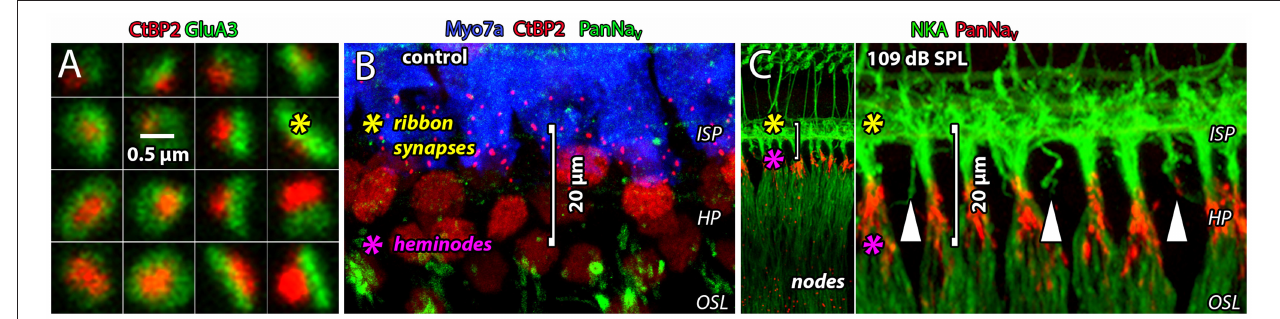
FIGURE 1 | Glutamatergic ribbon synapses and afferent fibers are vulnerable to noise exposure. (A) Square tiles ( ∼ 1 µ m 2 ) show 16 individual afferent ribbon synapses from the 2nd cochlear turn of a control cochlea. The presynaptic ribbon (red) is a cytoplasmic density anchored to the presynaptic membrane of the IHC. The main synaptic ribbon protein, Ribeye, is labeled with an antibody to CtBP2 which is the B-domain of Ribeye, and itself a nuclear transcription factor (Schmitz et al., 2000). The ribbon is juxtaposed to a large postsynaptic array of AMPARs (green). (B) The glutamatergic ribbon synapses in the ISP (red) are ∼ 20 µ m from the spike-generating heminodes at the HP (green). (C) Immediately after a 90-min exposure to 4–8kHz octave band noise at 109 dB SPL. Heminodes (red) are positioned at the habenula perforata (HP), just before ANFs become myelinated as they enter the osseous spiral lamina (OSL) toward the ganglion. Some dendrites in the ISP appear to be severed from their heminodes at the HP (vertical arrowheads). Spike-generating heminodes and nodes on ANFs express voltage-gated Na + channels (anti-Pan-NaV, red). In all panels, yellow and magenta asterisks indicate positions of ribbon synapses and heminodes, respectively.